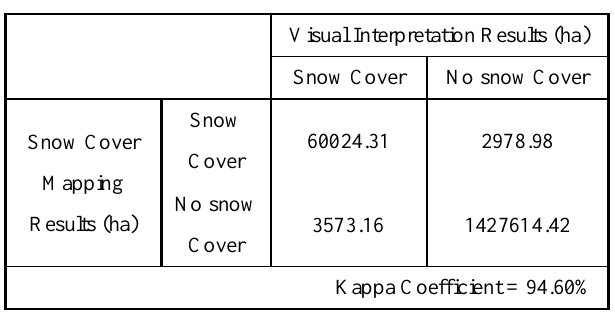
Figure 7. Comparison of the snow cover mapping result of the proposed method and that of Sentinel-1 after removal of the known water